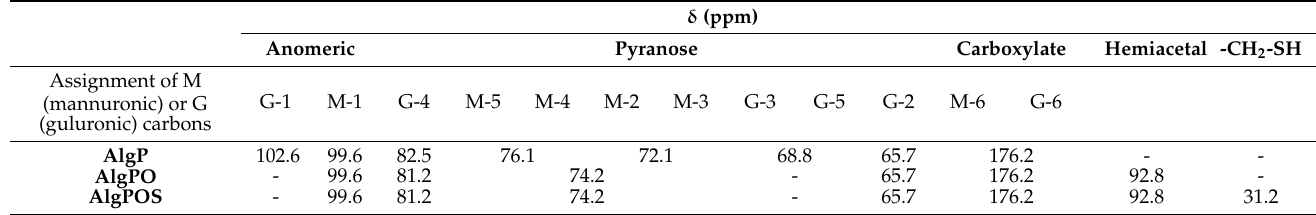
Table 2. Assignment of the chemical shifts by 13 C NMR in solid